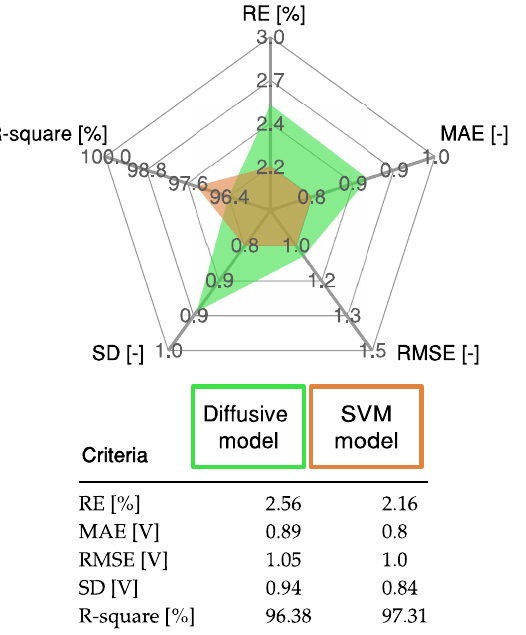
Figure 5. Results obtained from the voltage estimation using the proposed SVM model, ( above ) model input: FC current, ( medium ) real and estimated voltage from the SVM model and diffusive model, and ( below ) relative error between the real and estimated voltage from the SVM and diffusive models.